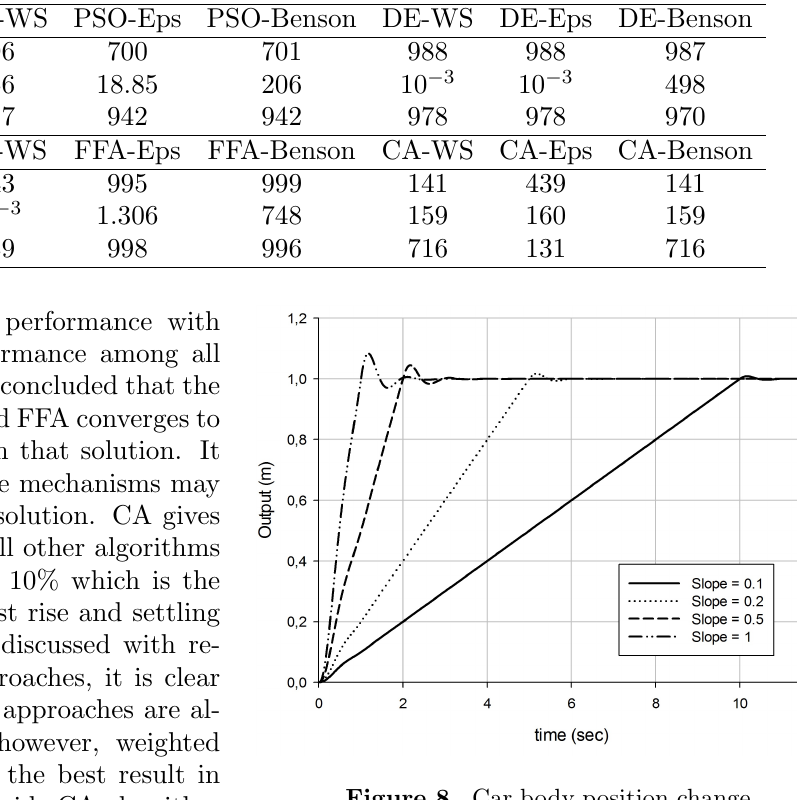
Figure 8. Car body position change for ramp input with different